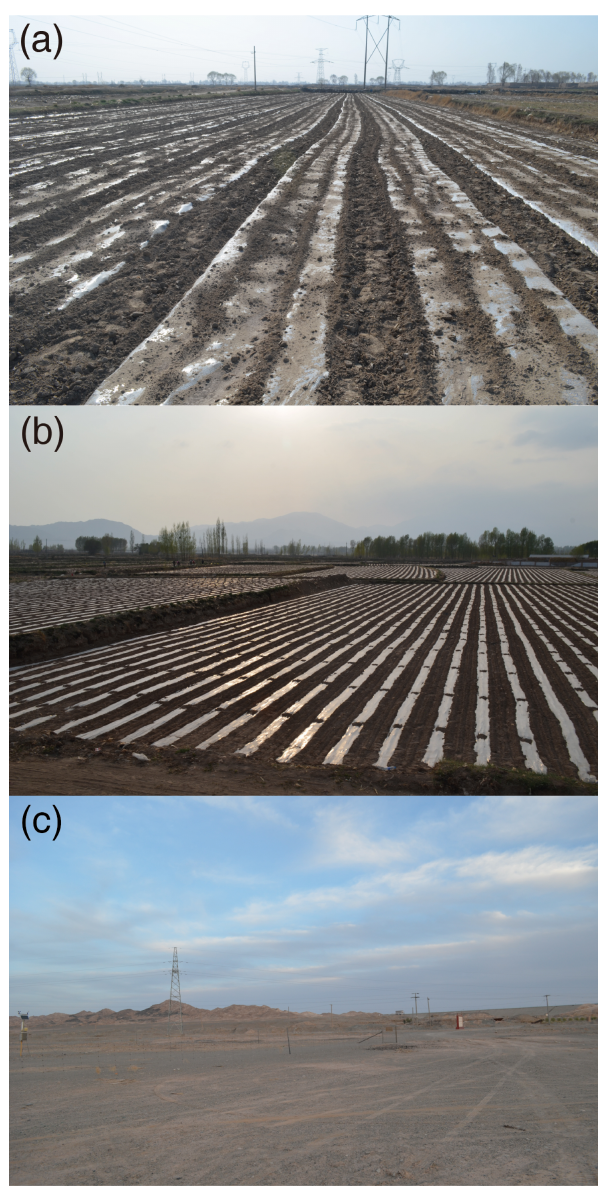
Figure 2. Same as Fig. 1 but for land surface conditions at (a) Huangyang farmland in Wuwei (HFW), (b) Linze farmland in Zhangye (LFZ), and (c) the Gobi Desert in Dunhuang (GDD).